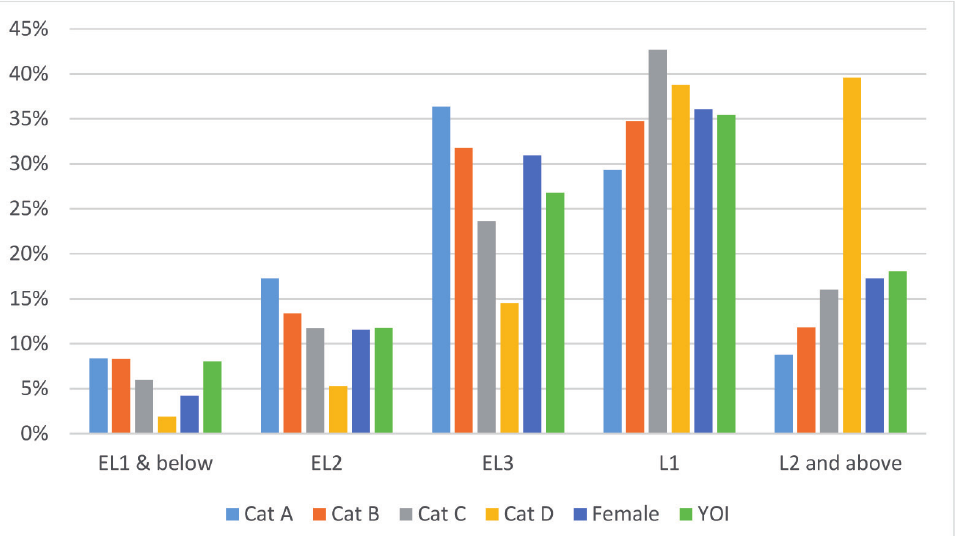
Figure 7: Prisoners’literacylevelsbyprisoncategory